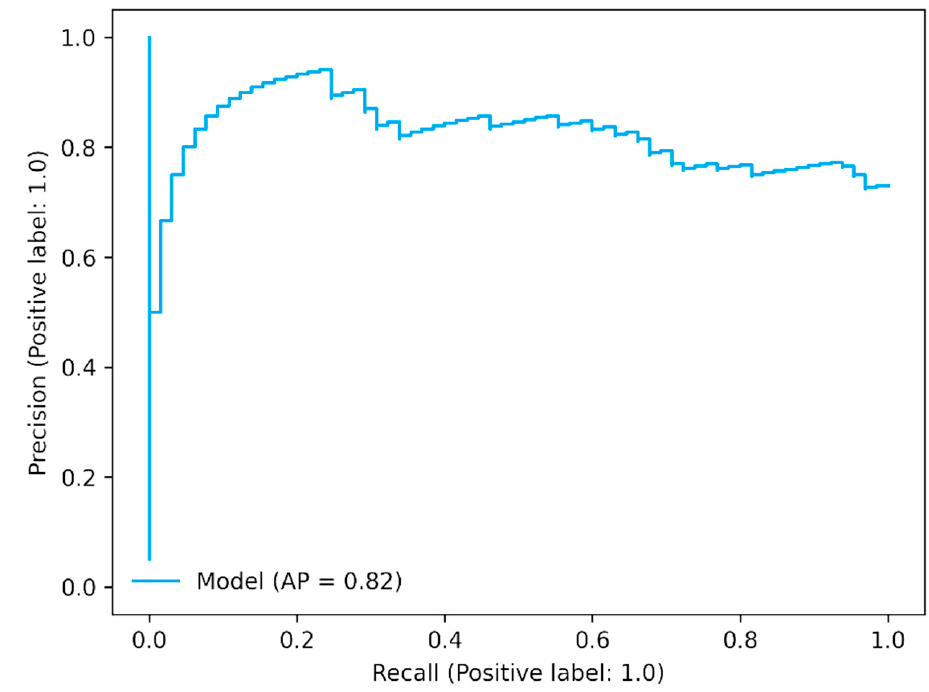
Figure 4. Precision–recall curve for meropenem.